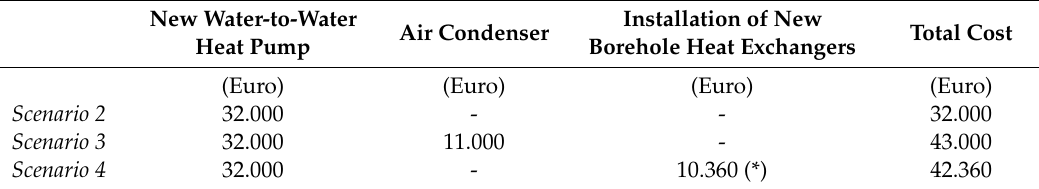
Table 4. Retrofit solutions costs.